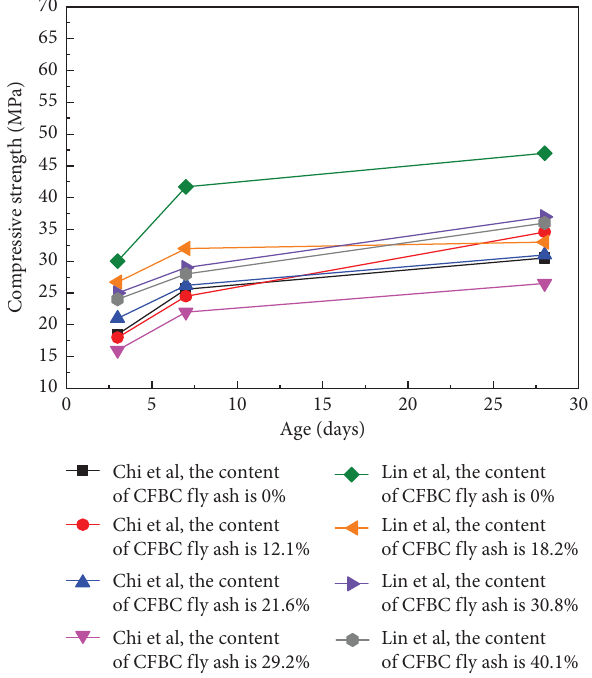
Figure 5: Infuence of age on compressive strength of RCC with diferent contents of CFB fy ash (rolling pressure � 50g · cm − 2 ) [56, 57].